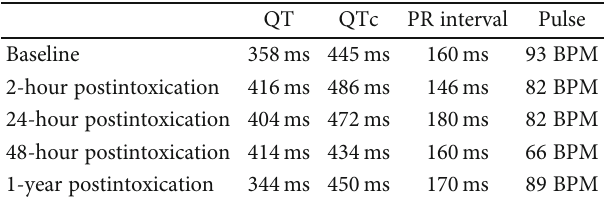
Figure 1: E ff ects of quetiapine on QTc on a patient with Wol ff -Parkinson-White (WPW) Syndrome. This graph represents changes in the QTc interval expressed in milliseconds at various points in time including at baseline, 2, 24, and 48 hours postoverdose and then fi nally a year after. Table 1: EKG parameters at baseline and several time points after quetiapine